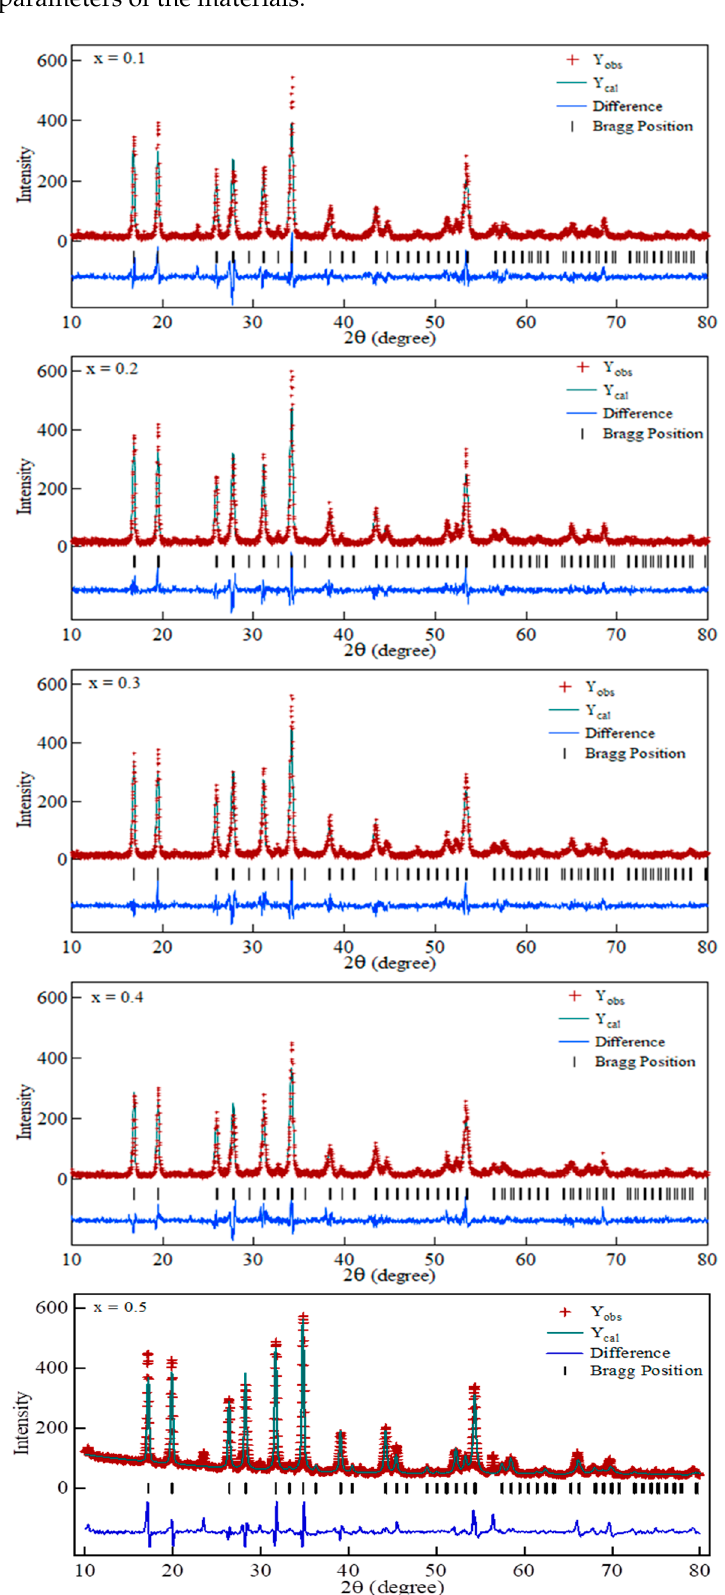
Figure 1. Rietveld refinement of XRD data of Li 5+2x La 3 Ta 2-x Ga x O 12 garnets. The results in Figure 1 indicate that LLT-Ga samples have cubic structure with the space group 𝐼𝑎3(cid:3364)𝑑 with an average lattice constant of 12.827 Å for x = 0.1–0.5 samples. The